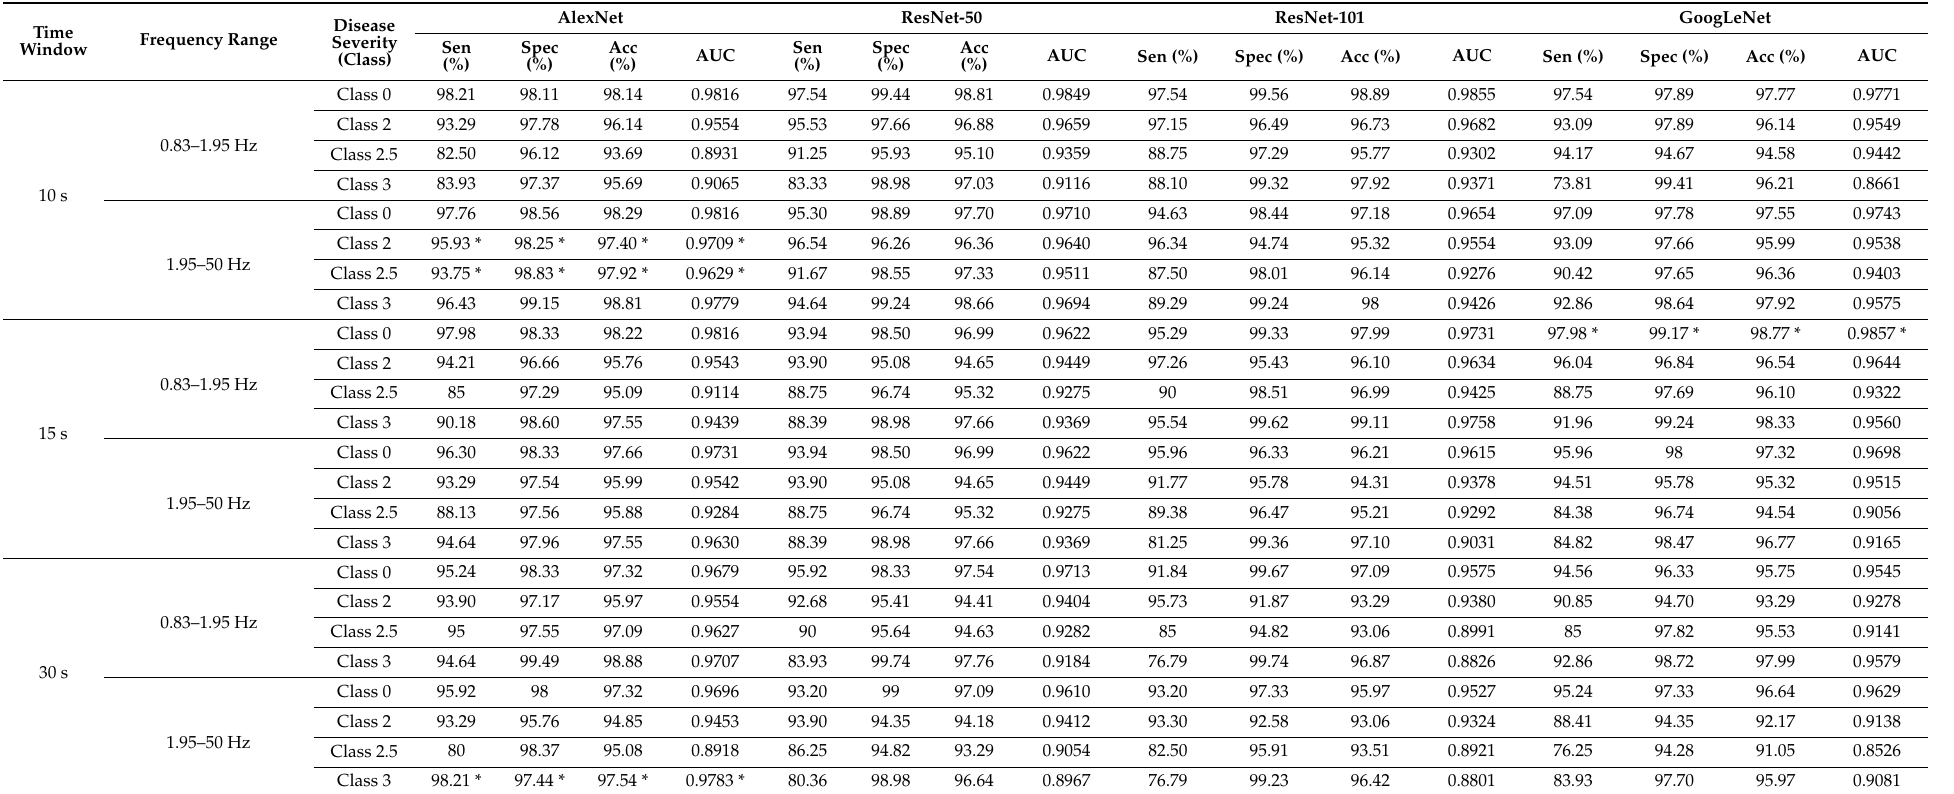
Table 5. Multi-class classification of LF from Ga dataset for CO (Class 0), PD Stage 2 (Class 2), PD Stage 2.5 (Class 2.5), and PD Stage 3 (Class 3) using several CNN classifiers (AlexNet, ResNet-50, ResNet-101, and GoogLeNet) with 10-fold